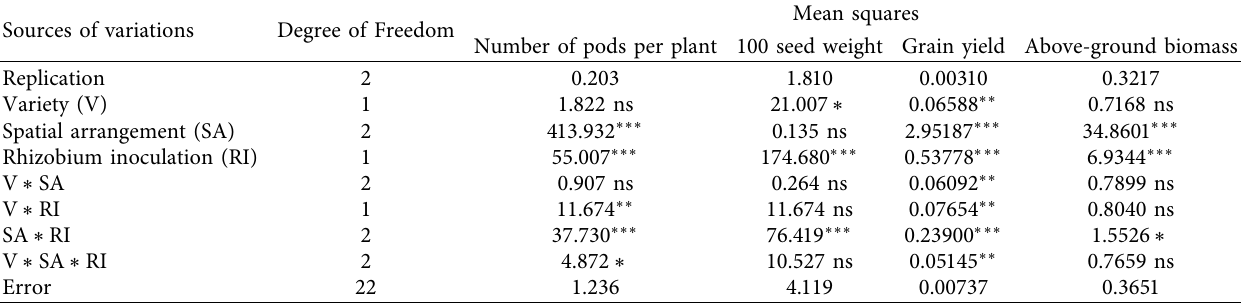
Table 8: Mean squares from analysis of variance (ANOVA) for number of pods per plant − 1 (NPPP), hhndred seed weight (100SW), grain yield (GY), and above-ground biomass (AGB) common bean.